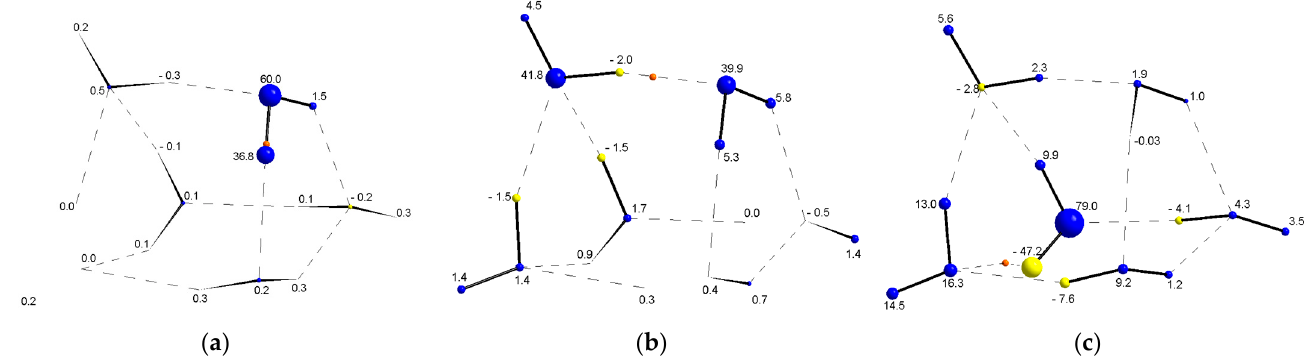
Figure 8. Pictorial representation of the SF contributions to 𝜌(𝐫 𝑩𝑪𝑷 ) at ( a ) a Od–H covalent bond, ( b ) strong O a ···H HB (i.e, 1 < |𝑉(𝐫 𝑩𝑪𝑷 )| 𝐺(𝐫 𝑩𝑪𝑷 )⁄ < 2 ) and ( c ) weak O a ···H HB (i.e., )| 𝐺(𝐫 )⁄ < 1 ). Blue color represents positive contributions (sources), whereas yellow color |𝑉(𝐫 𝑩𝑪𝑷 𝑩𝑪𝑷 ) | / G ( r ) < 1 ). Blue color represents positive contributions (sources), whereas yellow | V ( r BCP BCP represents negative SF contributions (sinks). color represents negative SF contributions